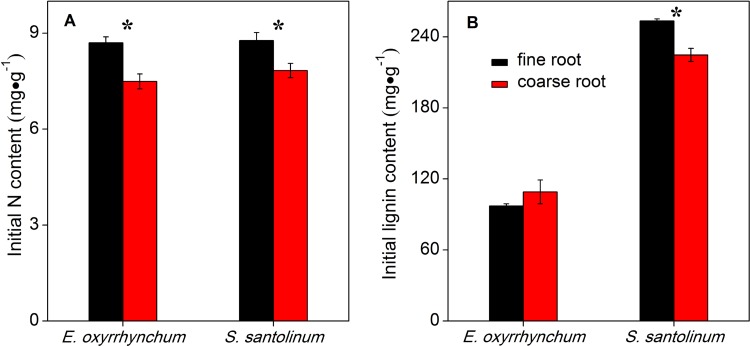
Initial N (A) and lignin (B) concentration of fine and coarse roots from E. oxyrrhynchum and S. santolinum in the second experiment (experiment II).* indicates significant differences between fine and coarse roots within each species (P<0.05). Vertical bars represent standard errors (n = 3).